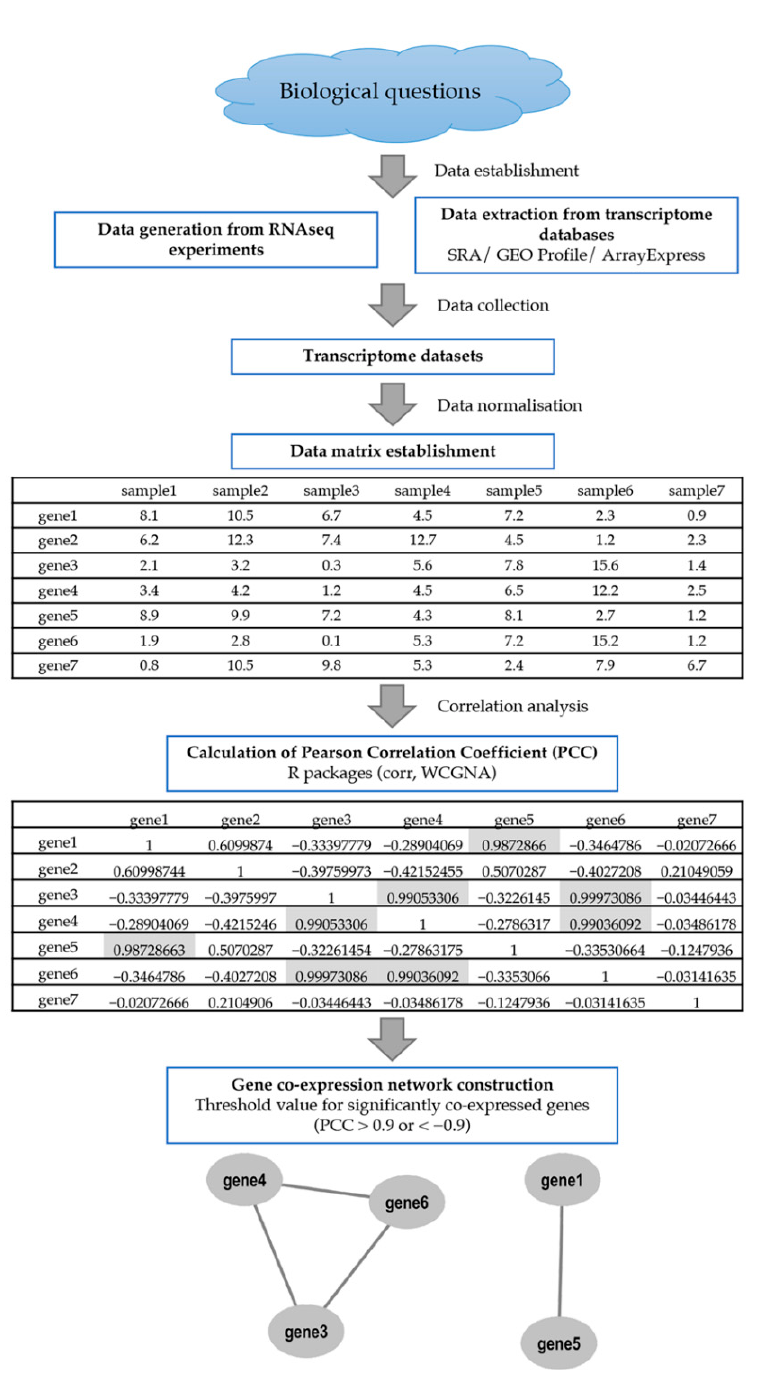
Figure 1. Summary of the gene co-expression network analysis pipeline. A co-expression network study is usually initiated by a biological question that would affect the experimental design of the RNA-seq and microarray experiments. The gene expression data can also be retrieved from transcriptome databases, i.e., SRA, GEO Profile and ArrayExpress. First, normalisation will be performed on the input transcriptome datasets. The generated data matrix comprises columns containing different samples and rows corresponding to genes. Next, the correlation analysis using the Pearson’s Correlation Coefficient (PCC) will be performed to calculate the degree of similarity between the gene expression profiles. Finally, the undirected GCN construction will calculate the whole gene pairs in the data matrix. The selected threshold value calculated by PCC to infer significantly co-expressed genes is >0.9 or < − 0.9, highlighted in